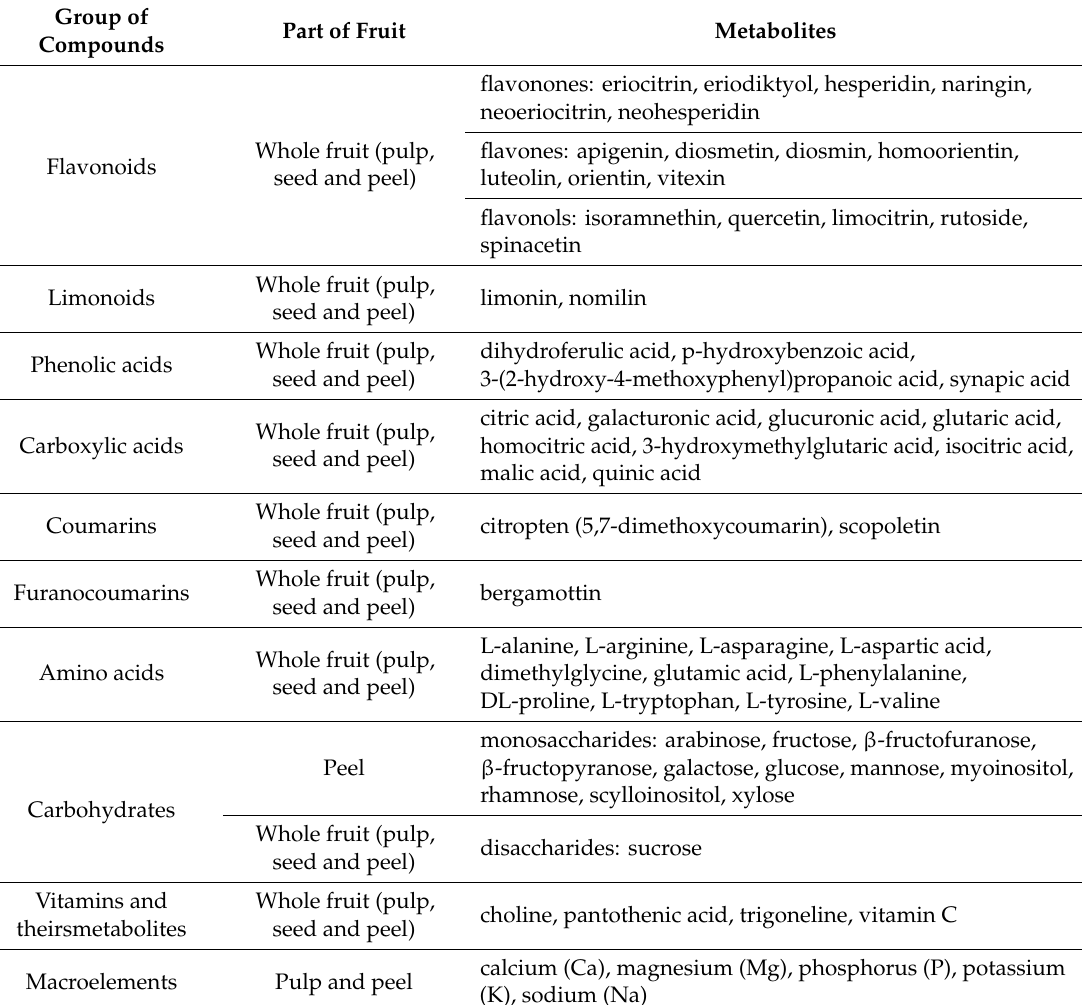
Table 3. Composition of C. limon fruits extracts.